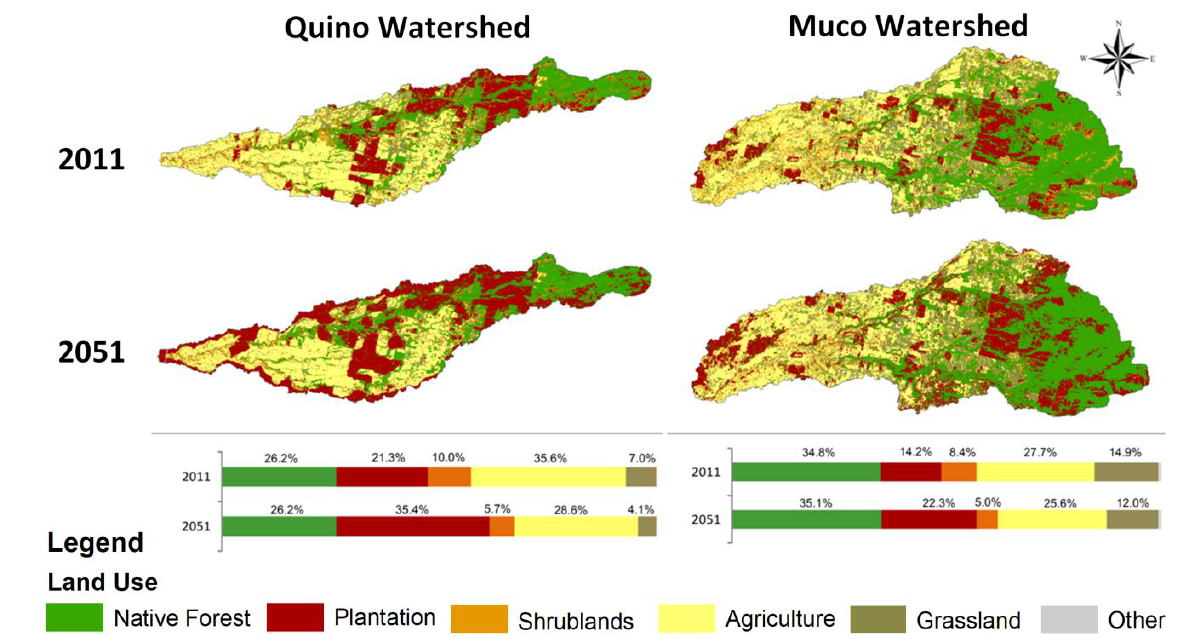
Figure 5. Spatial representation ( upper ) and percentage LUCC area ( lower ) for LU_2011y LU_2051 at theQuino and Muco watersheds.